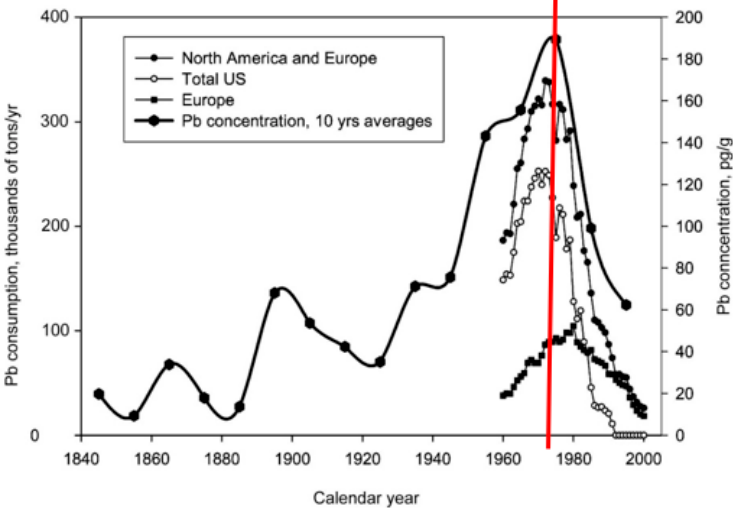
Figure 1. Rise and fall of lead aerosol deposition in Arctic ice before and after the 1975 introduction of unleaded gasoline to protect the catalytic converter, modified from [13].